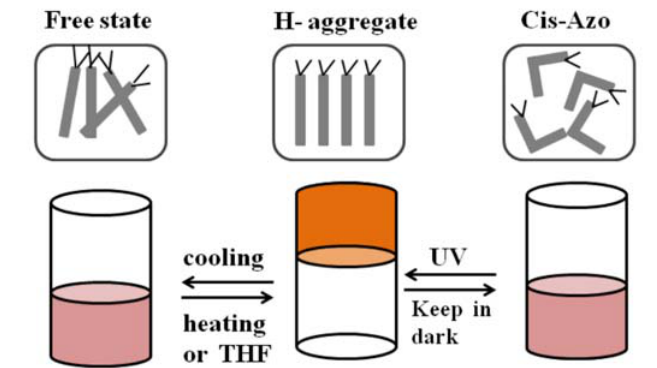
Figure 23. Organogels prepared with PM6AzCOOH in